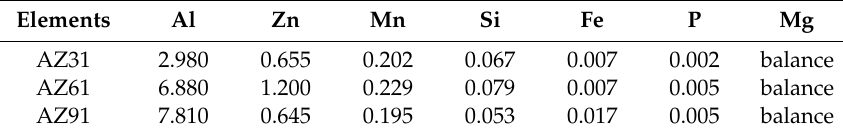
Table 1. The chemical composition of magnesium alloys in wt.